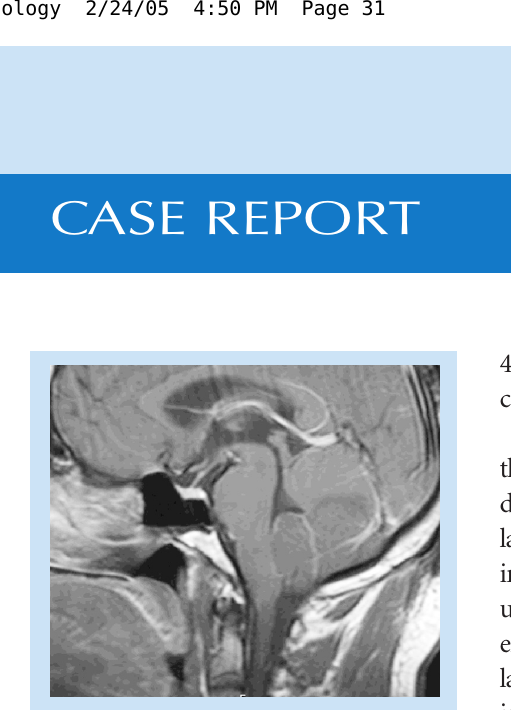
Fig. 2. Contrast-enhanced parasagittal coronal T1- weighted image reveals a hypo-intense mass with bands isodense to normal cerebellar tissue. A prominent vein is also noted draining into the straight sinus.